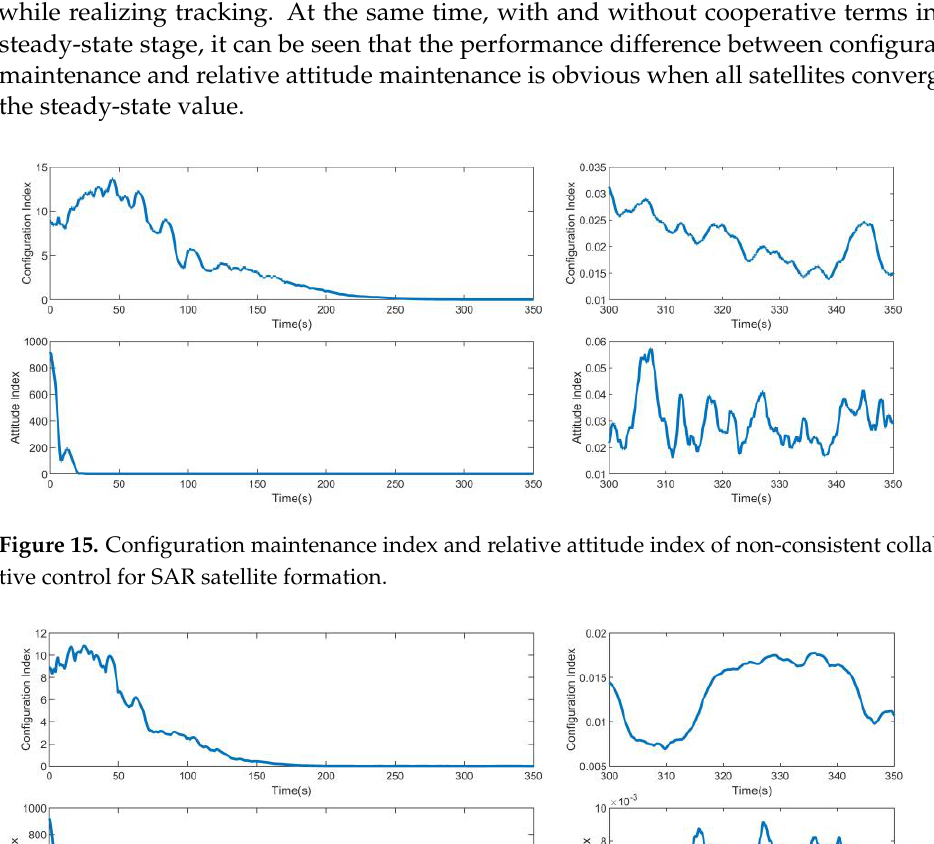
Figure 14. S1, S2, S3, S4 control torque for consistent collaborative control.